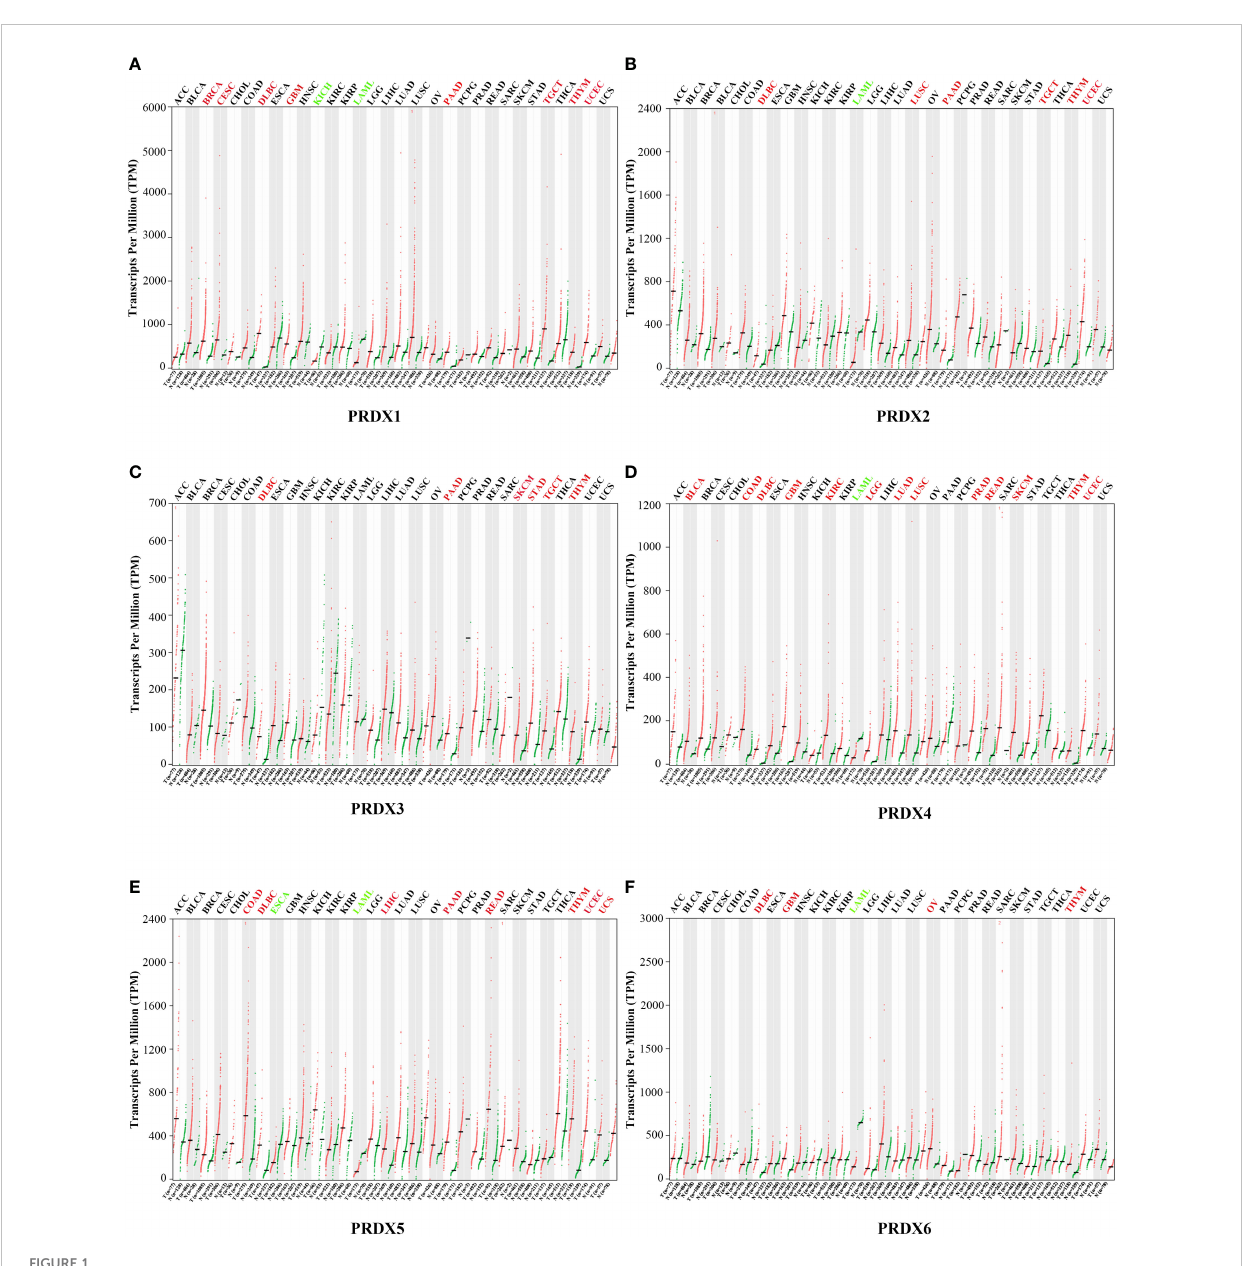
FIGURE 1 Expression of PRDX family members in various types of cancer (GEPIA). RNA-seq data for each PRDX family member in 31 cancer types are reported as TPM, generated by the TCGA. (A-F) Expression of PRDX1-6 in 31 cancers. The horizontal coordinate cancer name in red represents high expression, green represents low expression, and black represents no statistical signi fi cance. TPM, transcripts per million; TCGA, the cancer genome